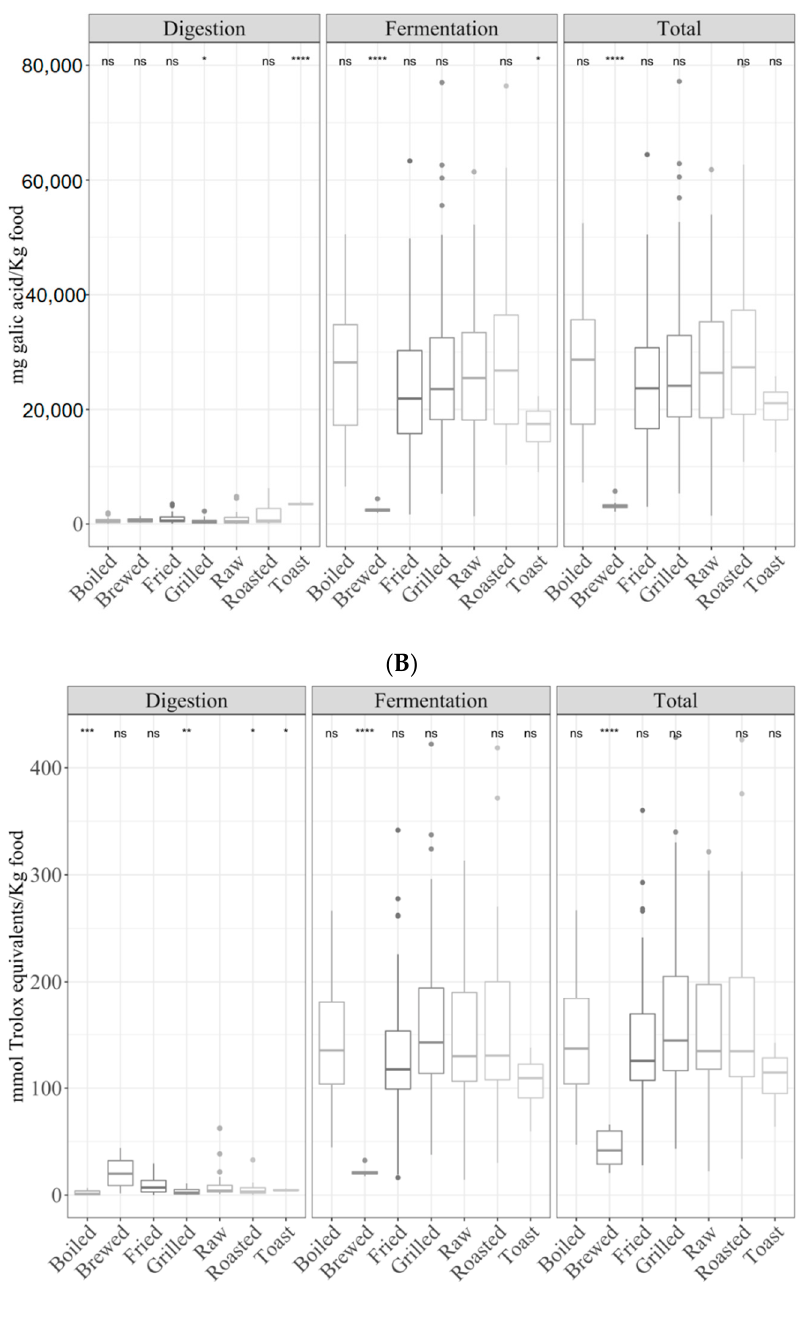
Figure 1. Antioxidant capacity of plant foods (obtained after in vitro digestion and fermentation) depending on the cooking technique ( A ) Trolox equivalent antioxidant capacity against DPPH radicals (TEAC DPPH ), ( B ) Folin–Ciocalteu and ( C ) for Trolox equivalent antioxidant capacity referred to reducing capacity (TEAC FRAP )). Statistical analysis was performed via ANOVA using raw vegetables as the reference group. Statistic labels: *: p < 0.05, **: p < 0.01, ***: p < 0.001, ****: p < 0.0001, ns: not significant. Similarly to the fermented fraction, the total antioxidant capacity of boiled and roasted foods was lower ( p < 0.05) than that of raw foods (Figure 1A). Overall, for most of the cooking techniques, the contribution of the digested fraction to the total antioxidant capacity was around 10% (Figure 2) but for brewed foods (accounted for 23%) and toasted plant foods (just